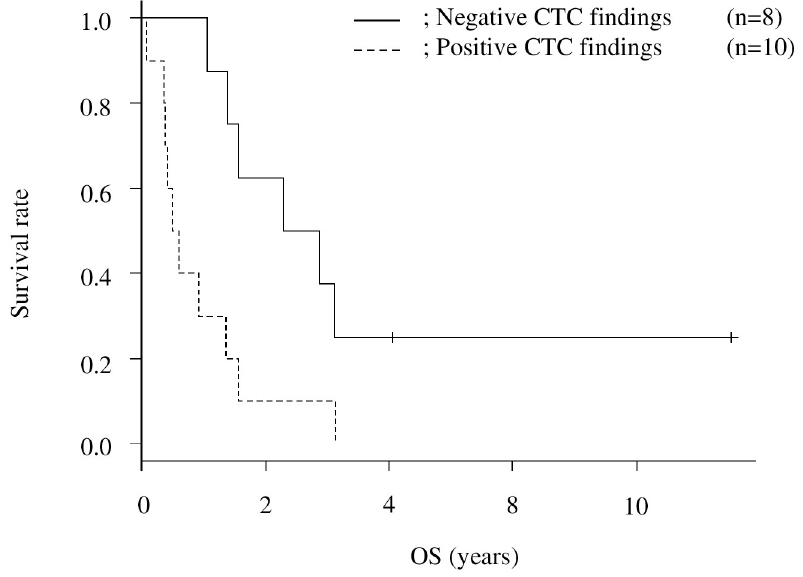
Fig 4. Kaplan–Meier survival curves for overall survival (OS) after computed tomography colonography (CTC).